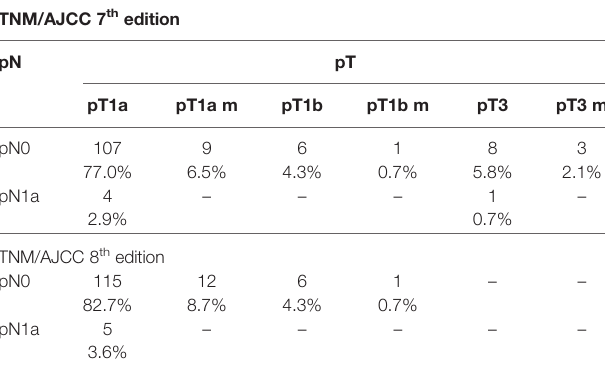
TABLE 2 | Postoperative advancement of pTNM, including multifocal disease (m) in 139 PGcT1aN0M0 patients according to the TNM/AJCC 7 th or 8 th edition.